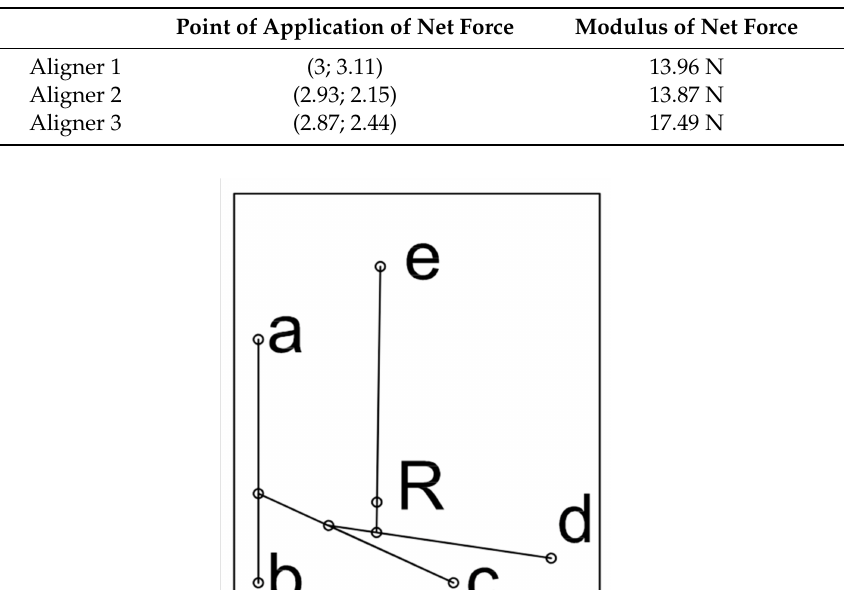
Table 4. Values for resulting force and their points of application on the three active aligners studied.